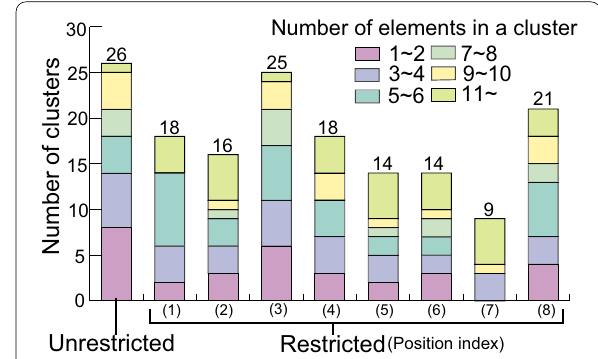
Fig. 16 Number of clusters and elements in a cluster